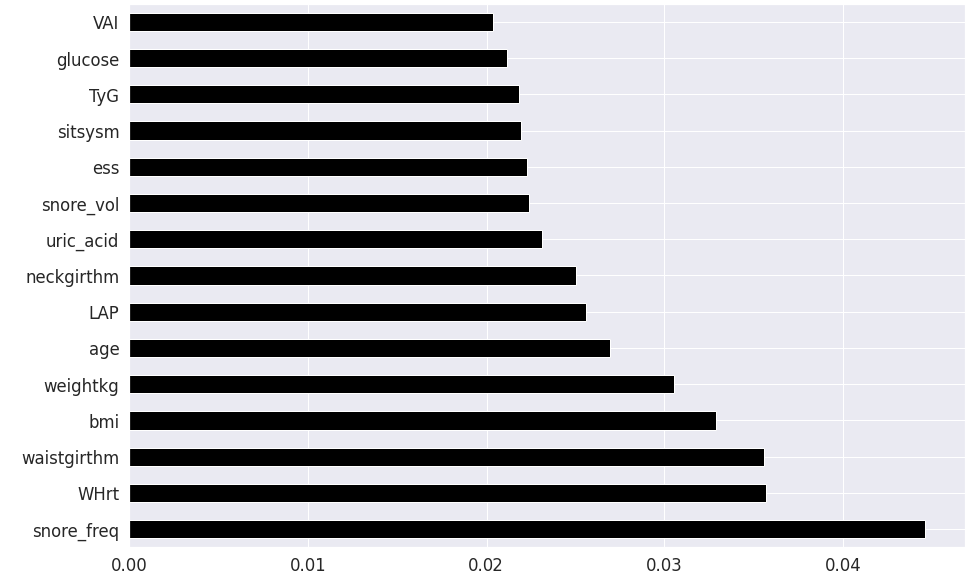
Figure 4. Clinical features ordered as per Extremely Randomized